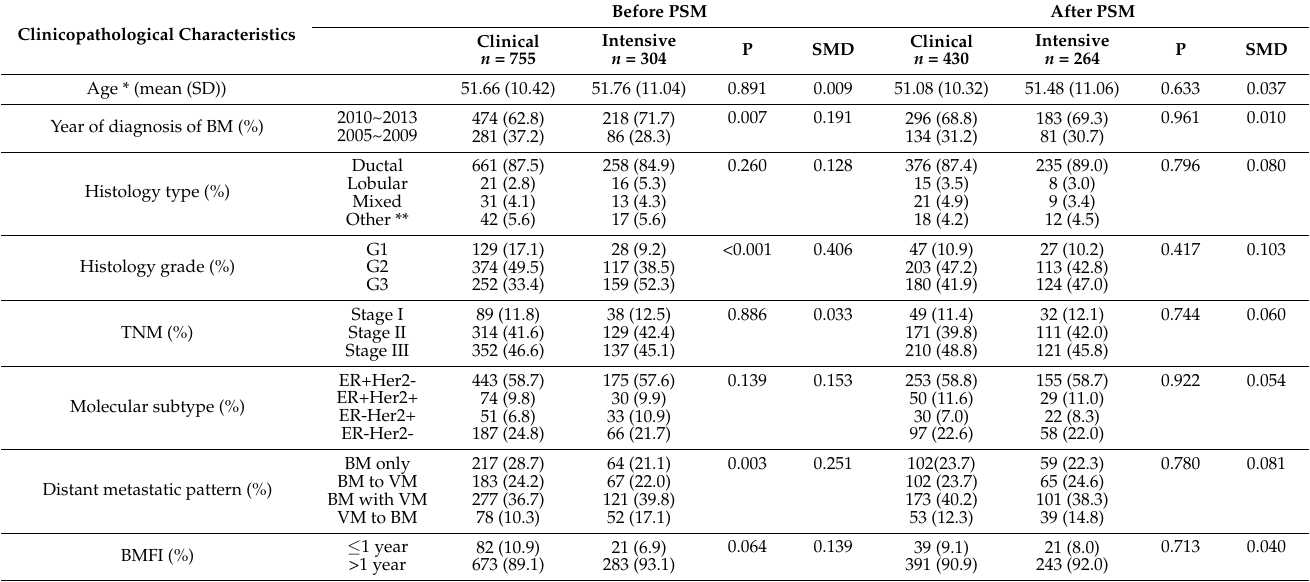
Table 1. Clinicopathological characteristics of eligible patients (N = 1059) stratified by postoperative follow-up strategy (Clinical postoperative BS vs. Intensive postoperative BS) before and after